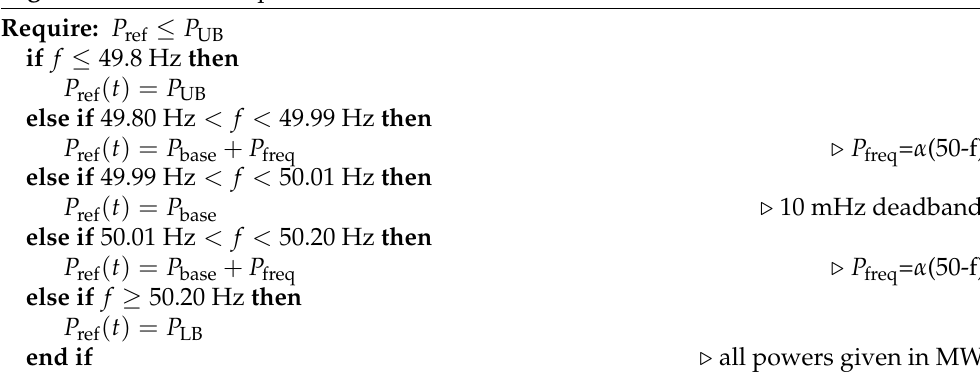
Algorithm 1 Reference power decision.